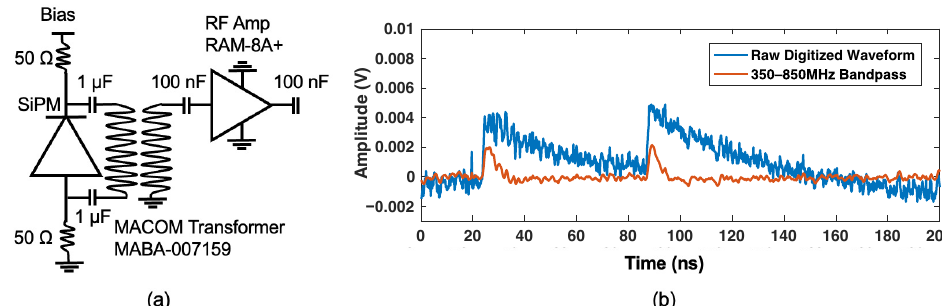
Figure 3. A schematic of the front-end readout circuit used for evaluation of Hamamatsu S13360-6075 SiPMs is shown in ( a ). An example, raw digitized trace from dark counts from a SiPM, along with the same trace with a 350–850 MHz bandpass, is shown in ( b